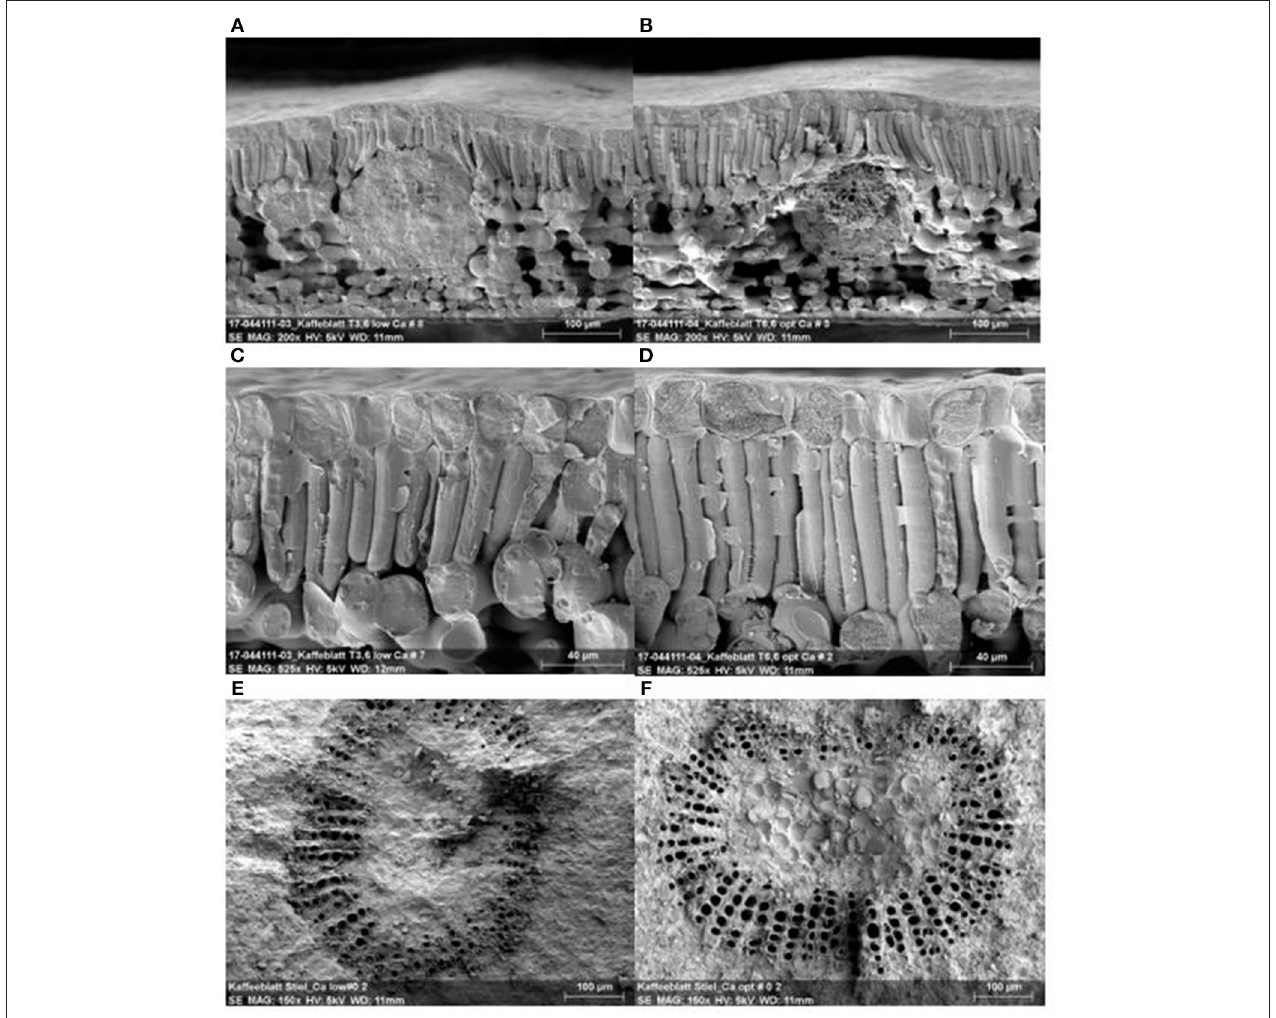
FIGURE 7 | Leaf structure with low and optimum Ca + 2 applications. Leaf cross section with low Ca + 2 (A) , and optimum Ca + 2 (B) , leaf epidermal and palisade cell with low Ca + 2 (C) and optimum Ca + 2 (D) , leaf petiole vascular bundle for low Ca + 2 (E) leaf petiole vascular and optimum Ca + 2 (F)